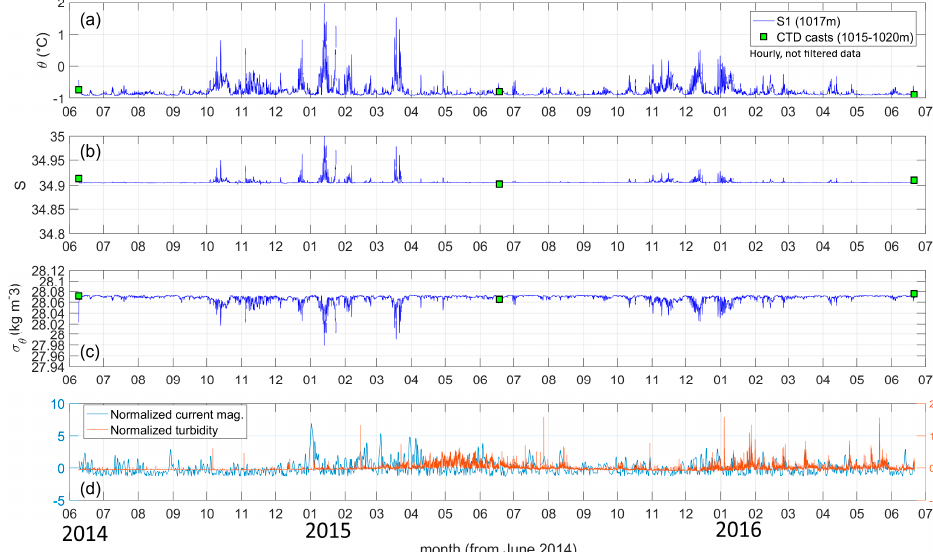
Figure 4. Time series (hourly data) of θ ( a ), S ( b ), and σ θ ( c ) at S1 (1017 m depth). Green squares show data extracted from CTD casts ( θ and S) at depths close to the moored instrument. Panel ( d ) shows normalized values of current magnitude (1022 m) and turbidity (1017 m). Data span from June 2014 to June 2016.